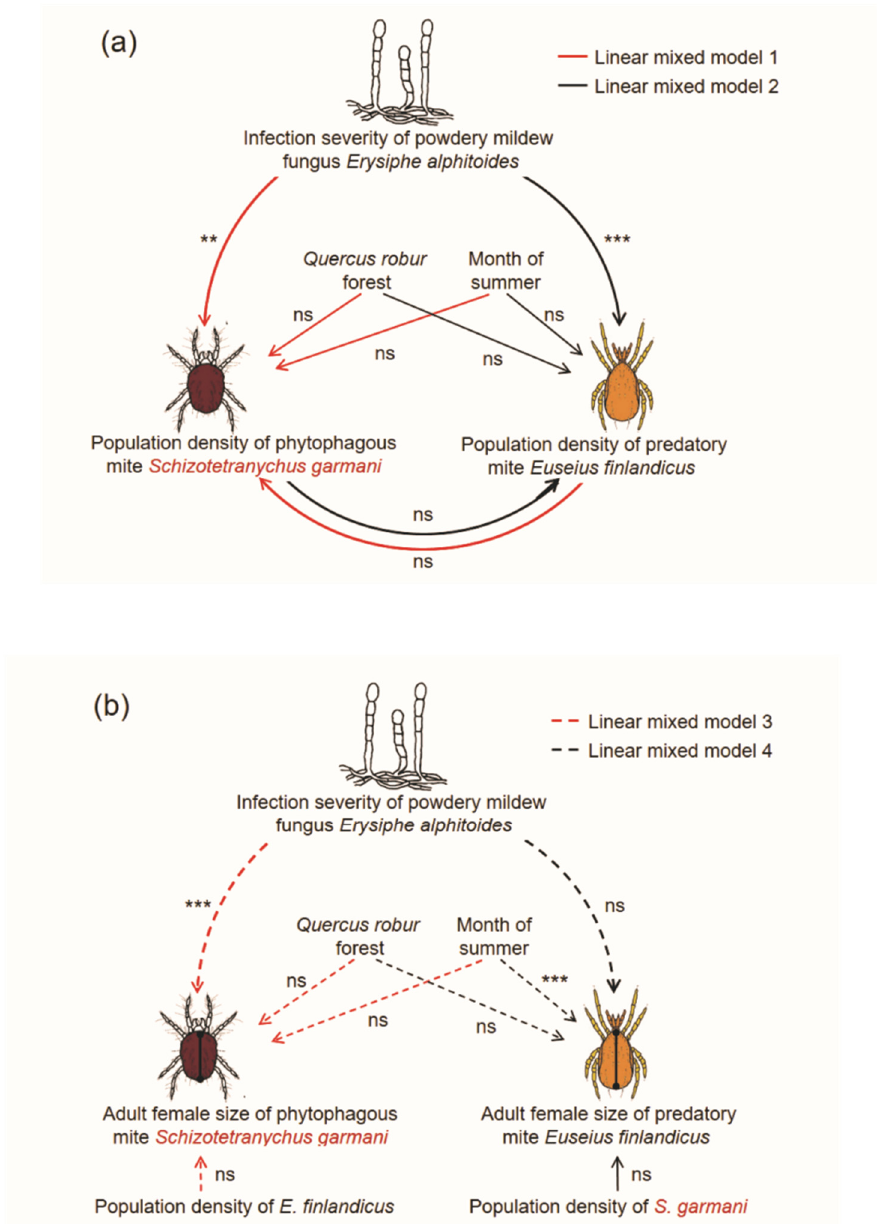
Figure 5. Summary of relationships in Quercus robur leaves between ( a ) population densities of Schizotetranychus garmani and Euseius finlandicus and ( b ) adult female idiosoma size of S. garmani and E. finlandicus and severity of Erysiphe alphitoides , the forest and the summer month. Asterisks indicate significances at p < 0.05 (**) and p < 0.01 (***), and no significance (ns), obtained from the models shown in Table 1.